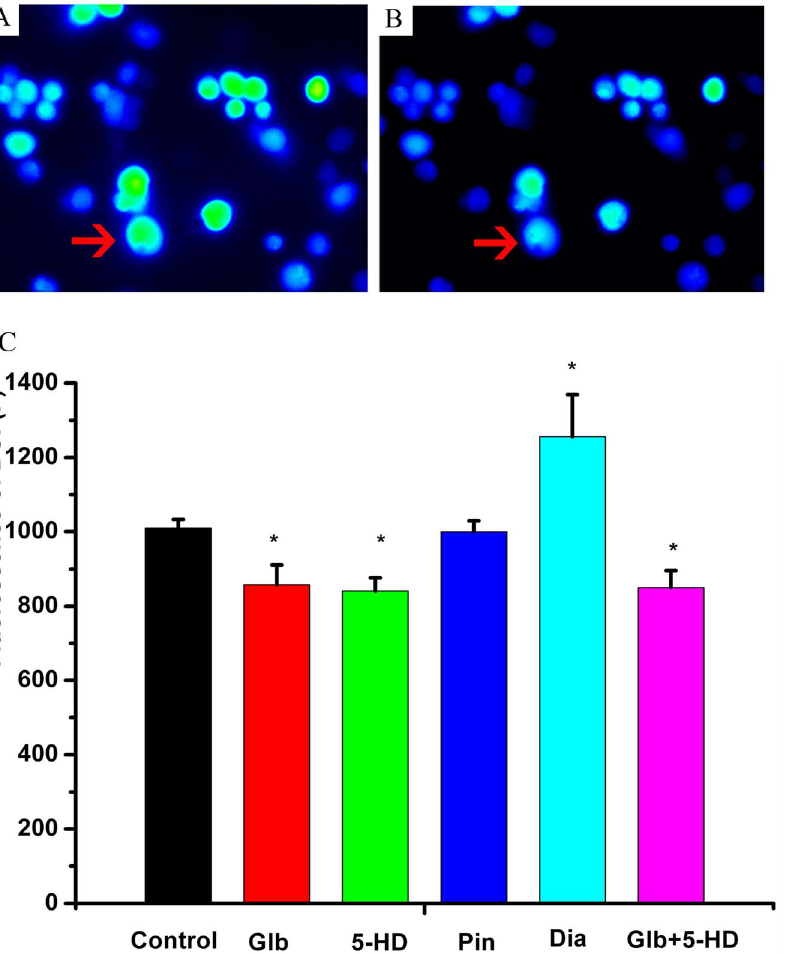
Figure 5. Effect of glibenclamide on intracellular ROS. A, representative intracellular ROS imaging in the control solution, the red arrow showed the fluorescence of dichlorofluorescein (DCF). B, representative ROS imaging with glibenclamide (100 m M). C, statistics of intracellular ROS levels with different agents. * P , 0.05, compared with the control.